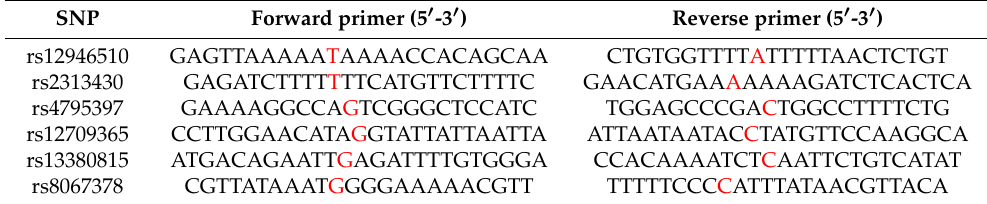
Table 3. Primers used for PCR